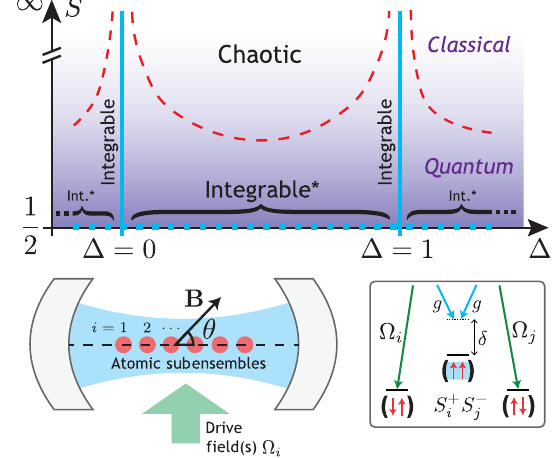
FIG. 1. (Top panel) The dynamical phase diagram of the model (1.2) in the plane of spin size S and anisotropy Δ . The main features are as follows: the integrable lines at Δ ¼ 0 and Δ ¼ 1 (solid blue lines), the novel integrable line at S ¼ 1 = 2 (dotted blue line and marked by an asterisk), and the onset of chaos at large S , indicated schematically by the dashed red curves. (Bottom-left panel) Schematic of the atomic subensembles (red) trapped inside a single-mode optical cavity (blue). A drive field (green) at a detuning δ from the cavity resonance generates effective spin-spin interactions between the atoms (bottom-right panel). The tunable angle θ between the spin quantization axis (along the applied magnetic field B ) and the cavity ’ s longitudinal axis leads to an anisotropy Δ ¼ 2 cot 2 θ . By changing the local atomic density in a region of constant coupling to the cavity mode, the effective spin size S can also be varied, allowing for the systematic exploration of the full phase